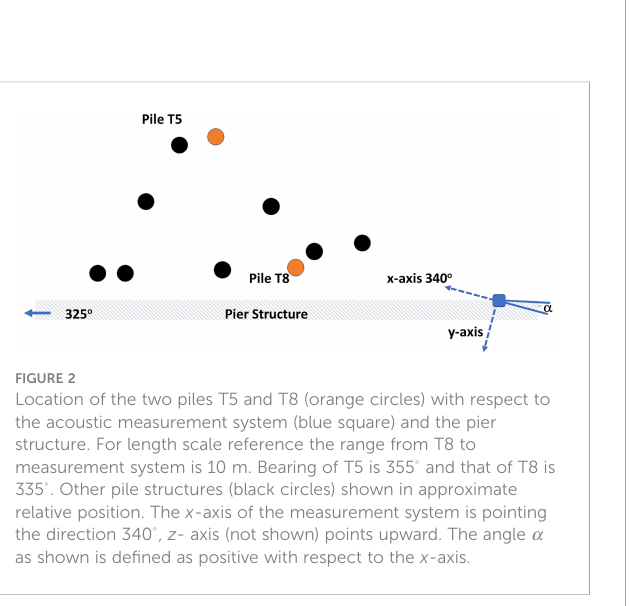
FIGURE 2 Location of the two piles T5 and T8 (orange circles) with respect to the acoustic measurement system (blue square) and the pier structure. For length scale reference the range from T8 to measurement system is 10 m. Bearing of T5 is 355 ∘ and that of T8 is 335 ∘ . Other pile structures (black circles) shown in approximate relative position. The x -axis of the measurement system is pointing the direction 340 ∘ , z - axis (not shown) points upward. The angle a as shown is de fi ned as positive with respect to the x